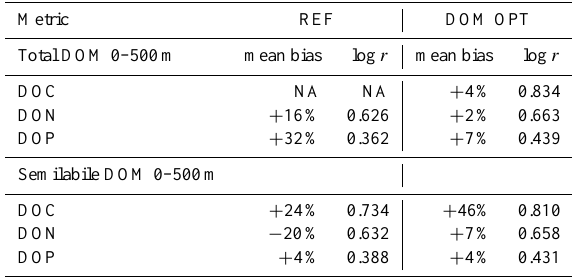
Table 3. DOM mean bias and correlation coefficient in relation to the DOM observations within the upper ocean (0–500m depth) for the REF and DOM OPT 1 ◦ simulations. Observations of semilabile DOM are calculated as the total observed DOM concentration less the asymptotic concentration below 1000m in each ocean